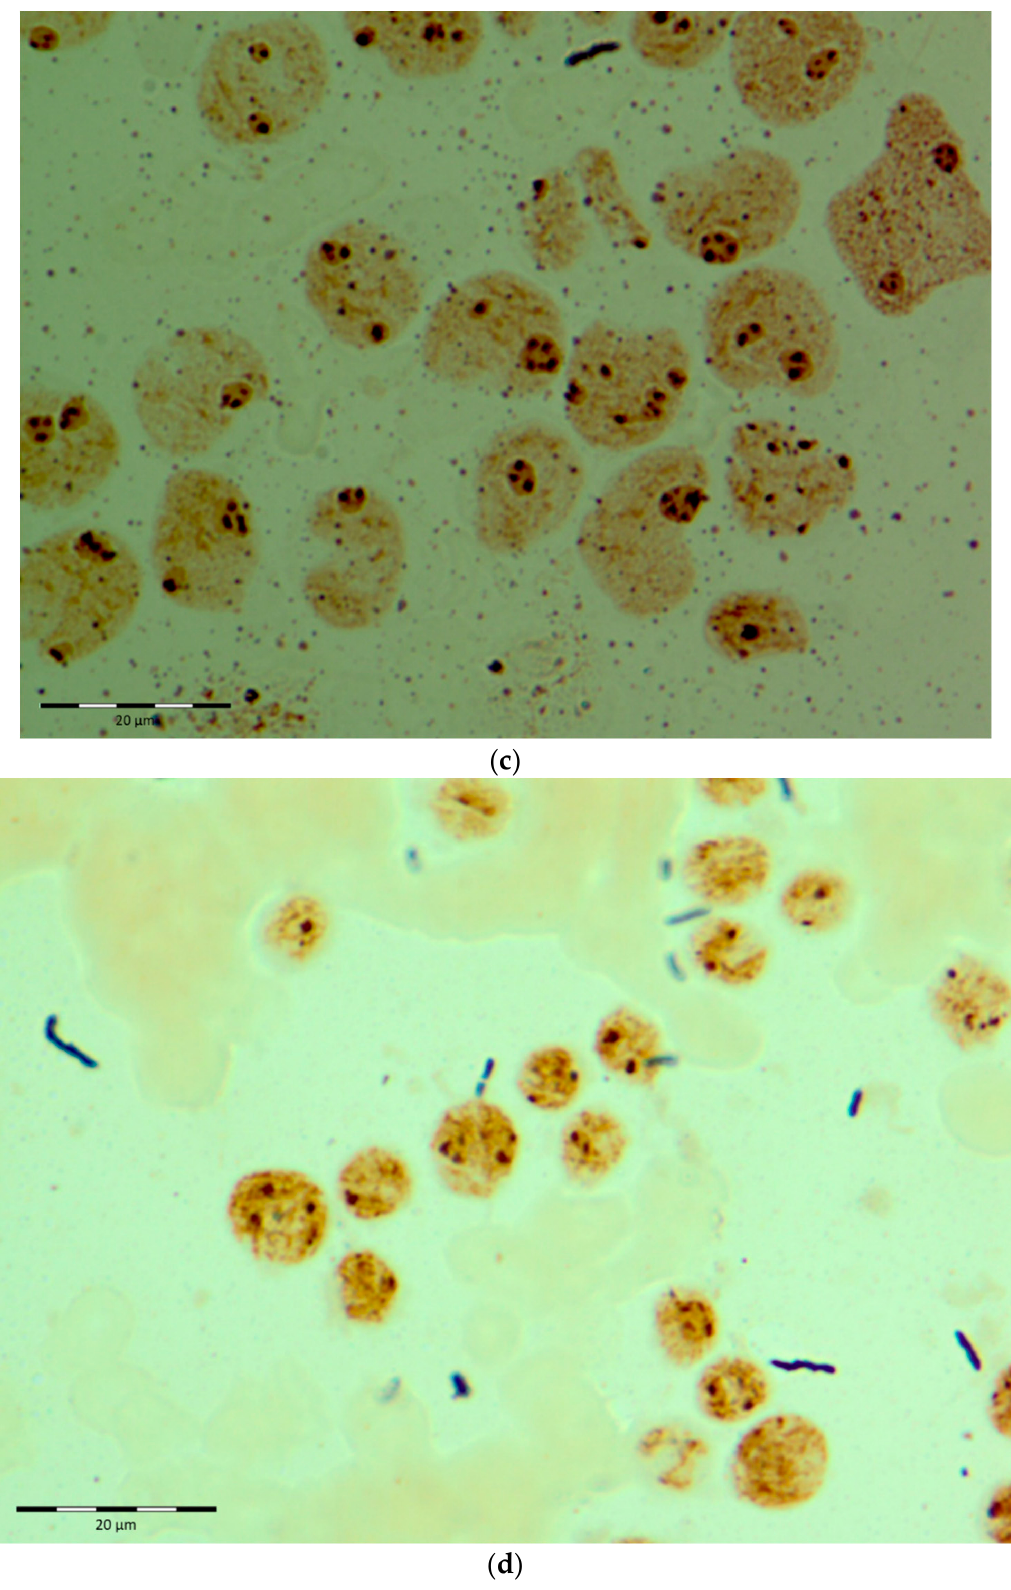
Figure 1. Exemplary results for AgNOR structure staining on bone marrow smears of selected patients: ( a ) M2 acute myeloid leukemia (ELN2); ( b ) M1 acute myeloid leukemia (ELN2); ( c ) M4 acute myeloid leukemia (ELN3); ( d ) acute lymphoblastic leukemia (Philadelphia+).